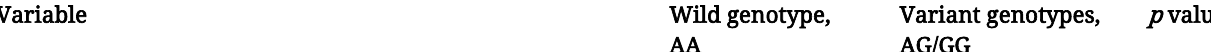
Table 3: Subgroup analysis according to cancer stage comparing patients with wild genotype to those with a variant